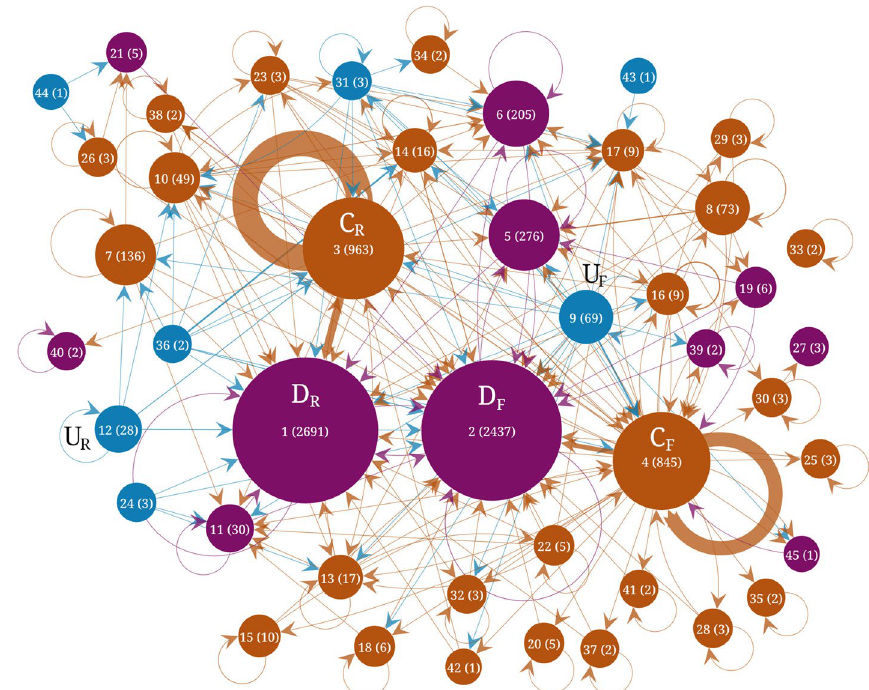
Fig. 5 Flow stability clustering of the telegram channels network G 2 (July 2019 to Feb. 2020). Nodes represent the communities and edges represents the number of links between channels in each community. Upstream communities are shown in blue, core communities in brown and downstream communities in purple. The labels indicate the rank of each community in terms of size and the size is indicated in